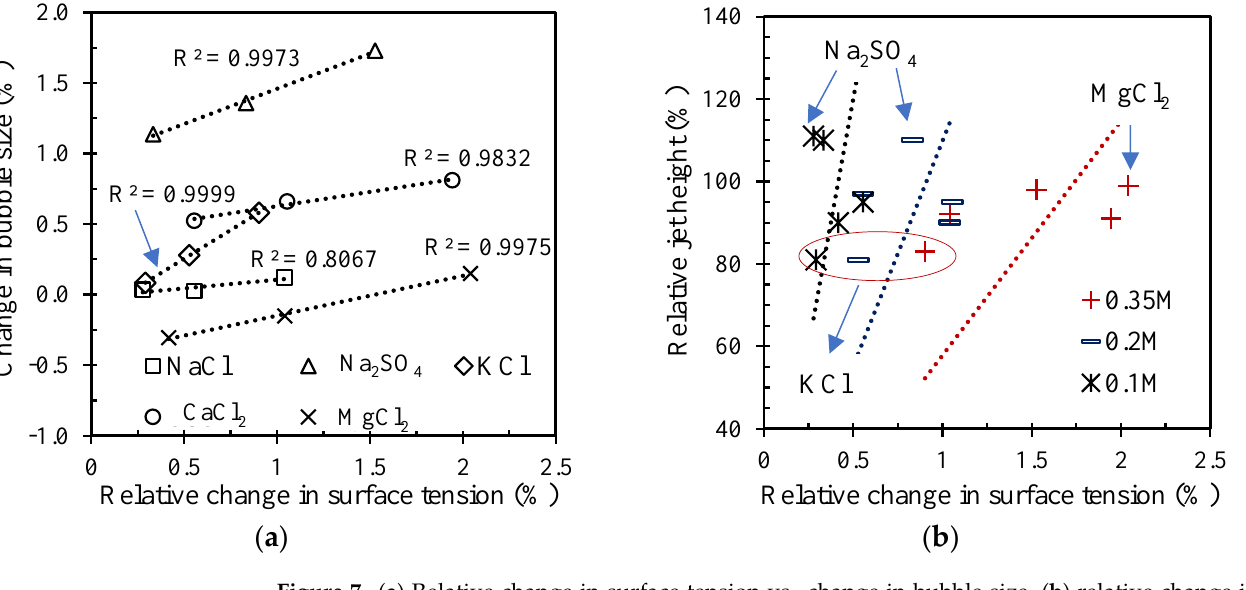
Figure 7. ( a ) Relative change in surface tension vs. change in bubble size, ( b ) relative change in surface tension vs. change in bubble size. A surface tension data range from 0.1 to 0.35 M was obtained from [16].